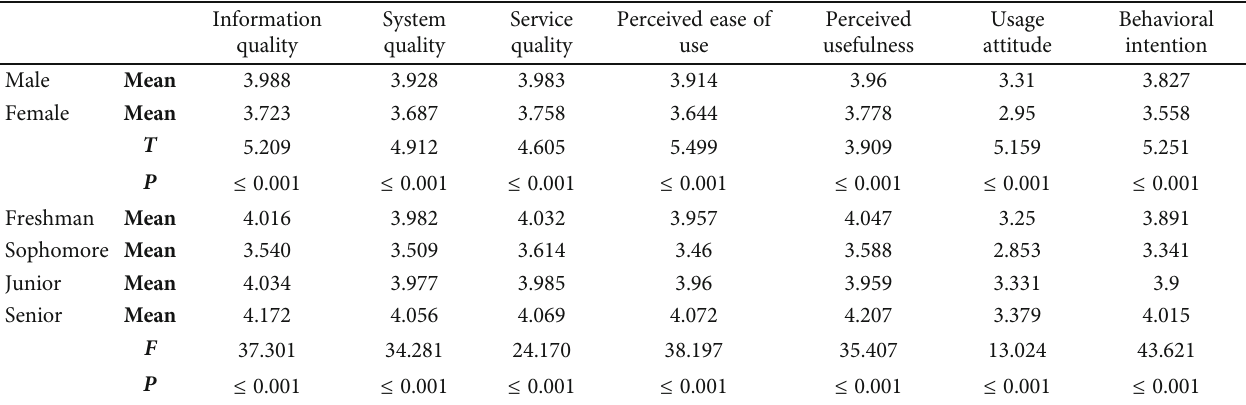
Figure 1: Hypothetical model of students ’ behavioral intention in network ideological and political learning. Table 2: Descriptive statistics of gender, grade, and core variables.